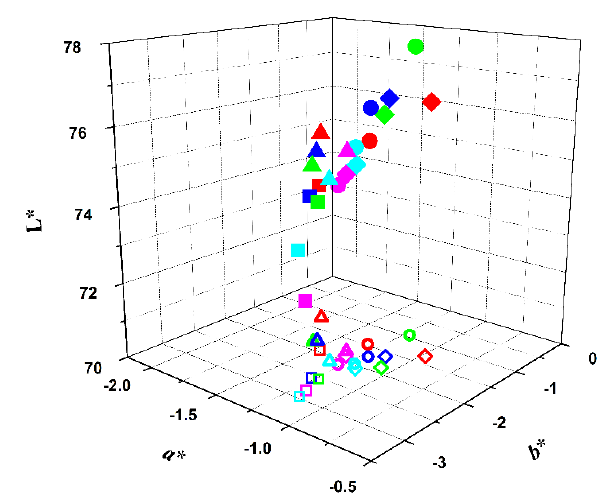
Figure 4. Representation of the colors of the several samples in L*a*b* color scheme, immediately after extract addition (red symbols), and after 1 day (green symbols), 7 days (blue symbols), 14 days (cyan symbols) and 21 days (magenta symbols) of storage at 4 C. Projection in a*,b* plane: open symbols. : red beetroot; Table 3. Encapsulation efficiencies, EE (%) ± SD (%), of the several plant extracts in soybean lecithin liposomes, prepared by either by ethanolic injection or thin film hydration (SD: standard deviation).